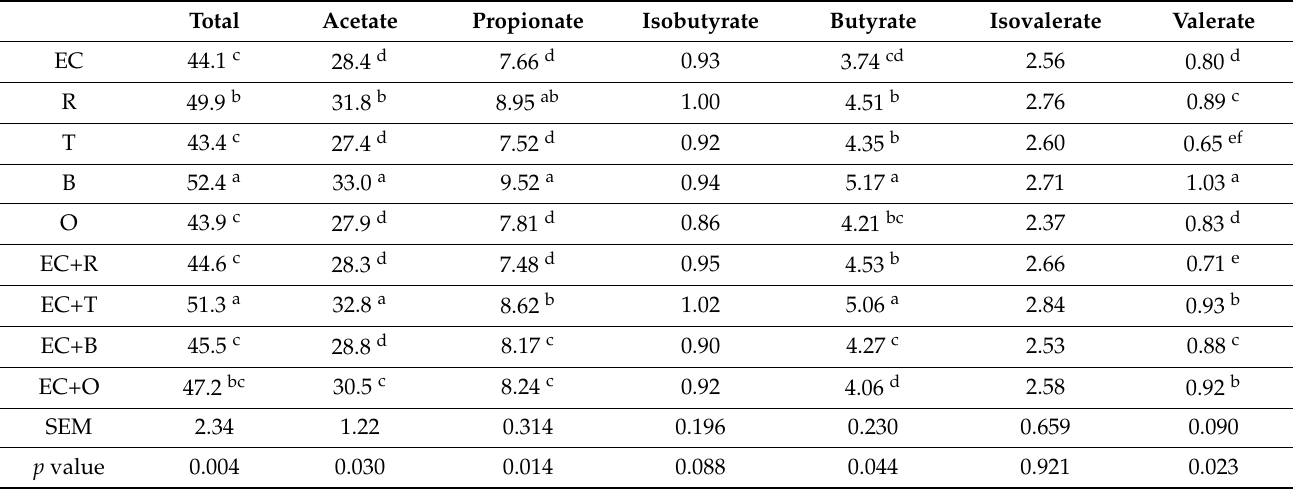
Table 5. Volatile fatty acids production (mmol/L) of intercropping of Egyptian